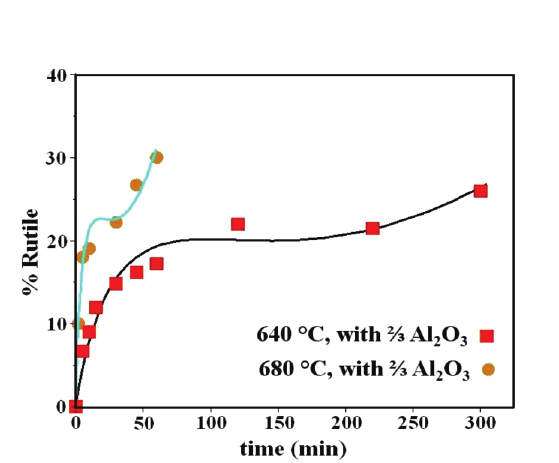
Fig. 4 – Arrhenius plot of the kinetic constants k for transformation from anatase to rutile (at T > 600 ºC)